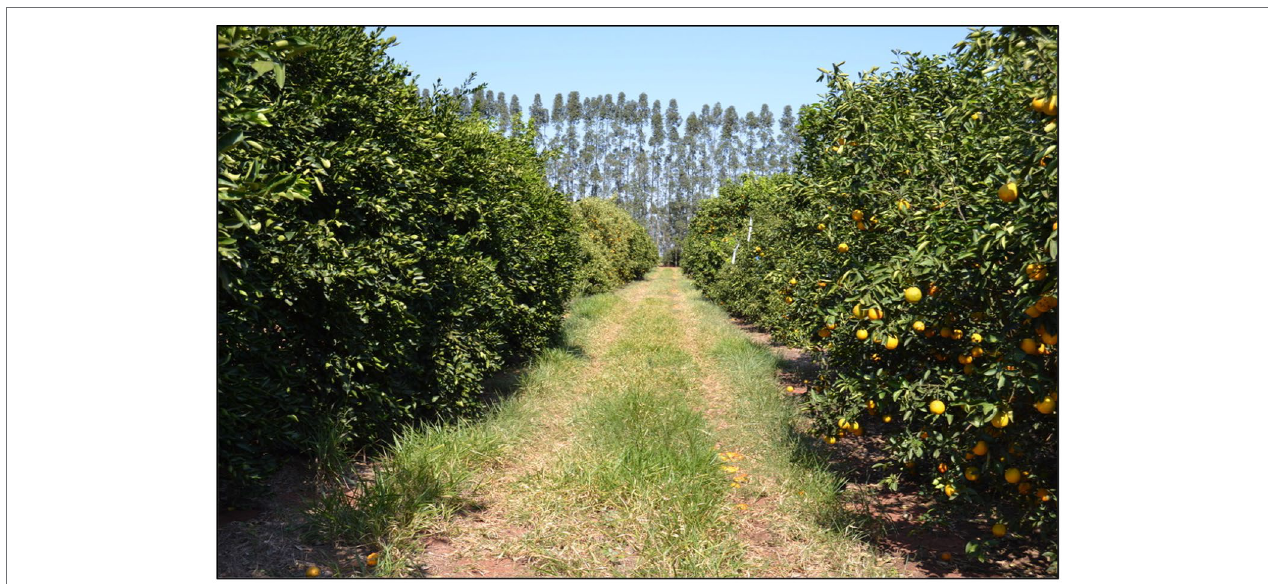
FIGURE 2 | Orchard arrangement of nine-year-old late-season sweet orange selections grafted onto Rangpur lime rootstock with two-row windbreaks of Eucalyptus grandis (Hill) ex Maiden (in the back) in Guairaçá, state of Paraná,